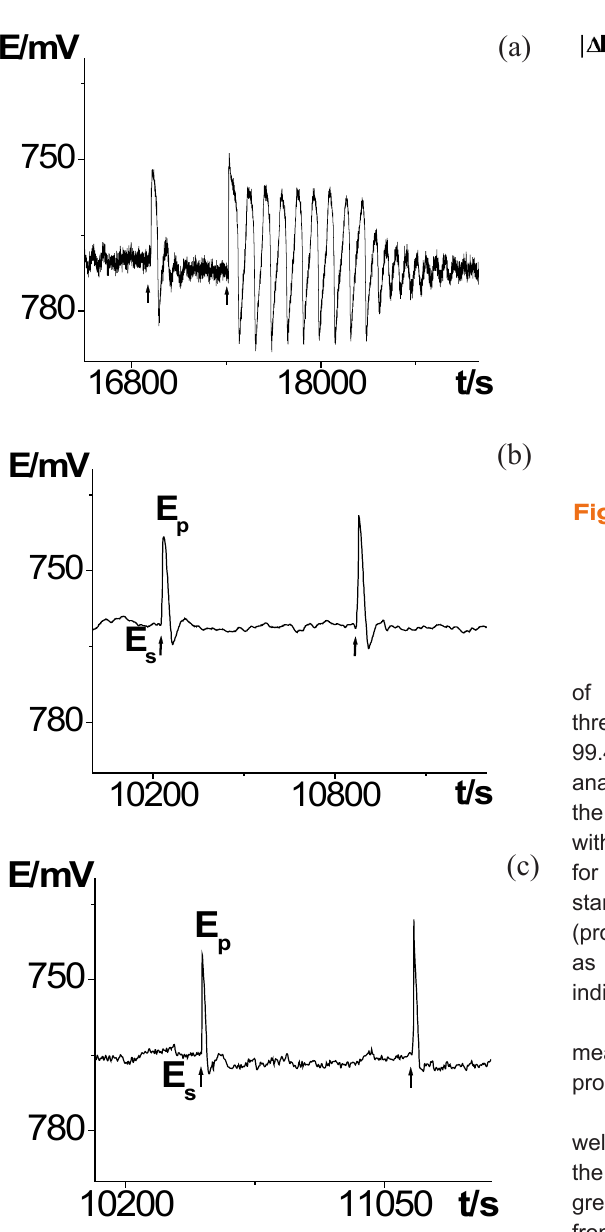
Figure 4. Typical potentiometric responses of the BL matrix